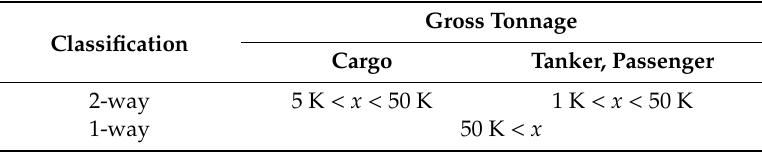
Table 1. Classification of the ships according to passage rules at the Incheon